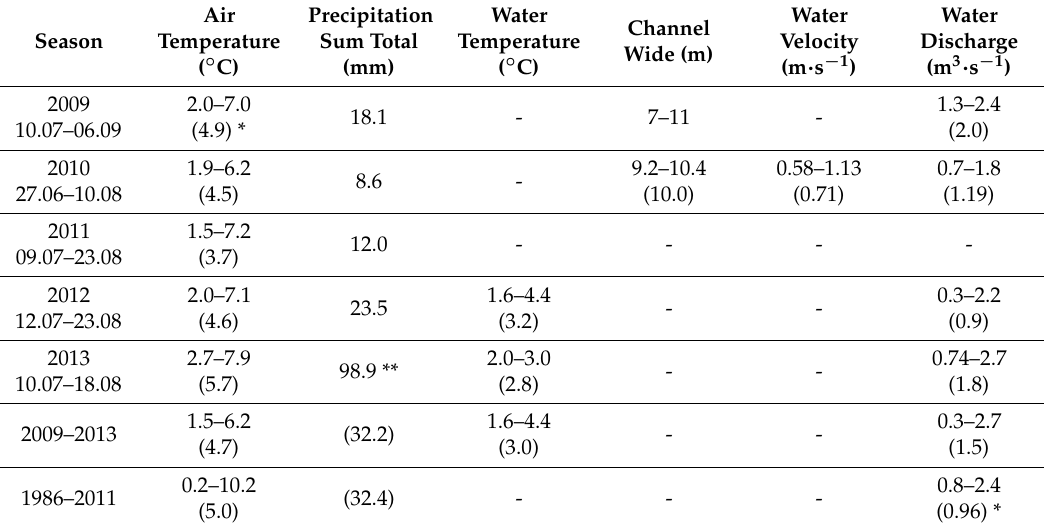
Table 1. Variability of selected hydro-meteorological components in the Scott River catchment in the years 2009–2013 relative to the multiannual averages. The data are presented by different sources: Kociuba, Janicki [27,56]; Kociuba et al. [29]; Medrak [58]; Franczak et al. [55]; Kociuba